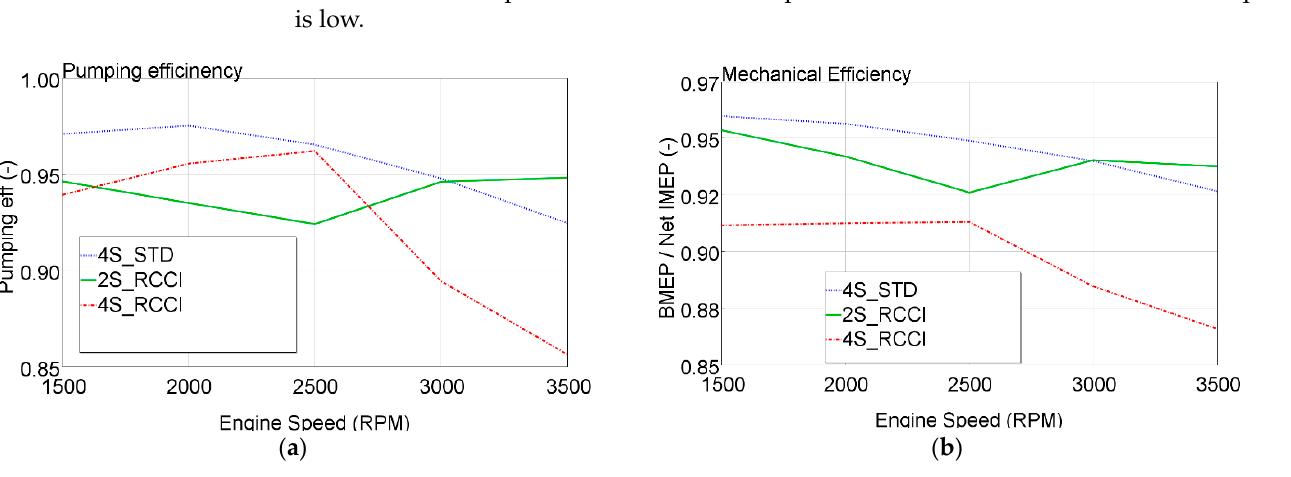
Figure 12. Pumping efficiency ( a ) and Mechanical efficiency ( b ) comparison between base diesel engine, 4-stroke RCCI engine, and 2-stroke RCCI engine. Operating point 1500–3500 rpm at full load.